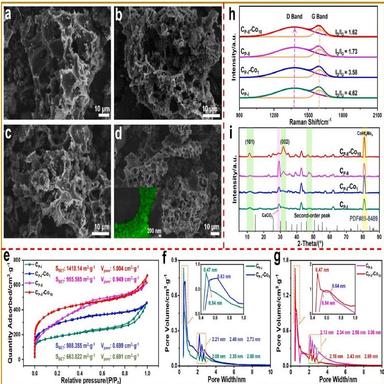
SEM images of samples: a) CP-I, b) CP-I-Co1, c) CP-II, and d) CP-II-Co10; e) N2 adsorption-desorption isotherms of samples, f) BJH pore size distribution of CP-I and CP-I-Co1, g) BJH pore size distribution of CP-II, and CP-II-Co10; h) Raman spectra of samples; and i) XRD spectra of samples.